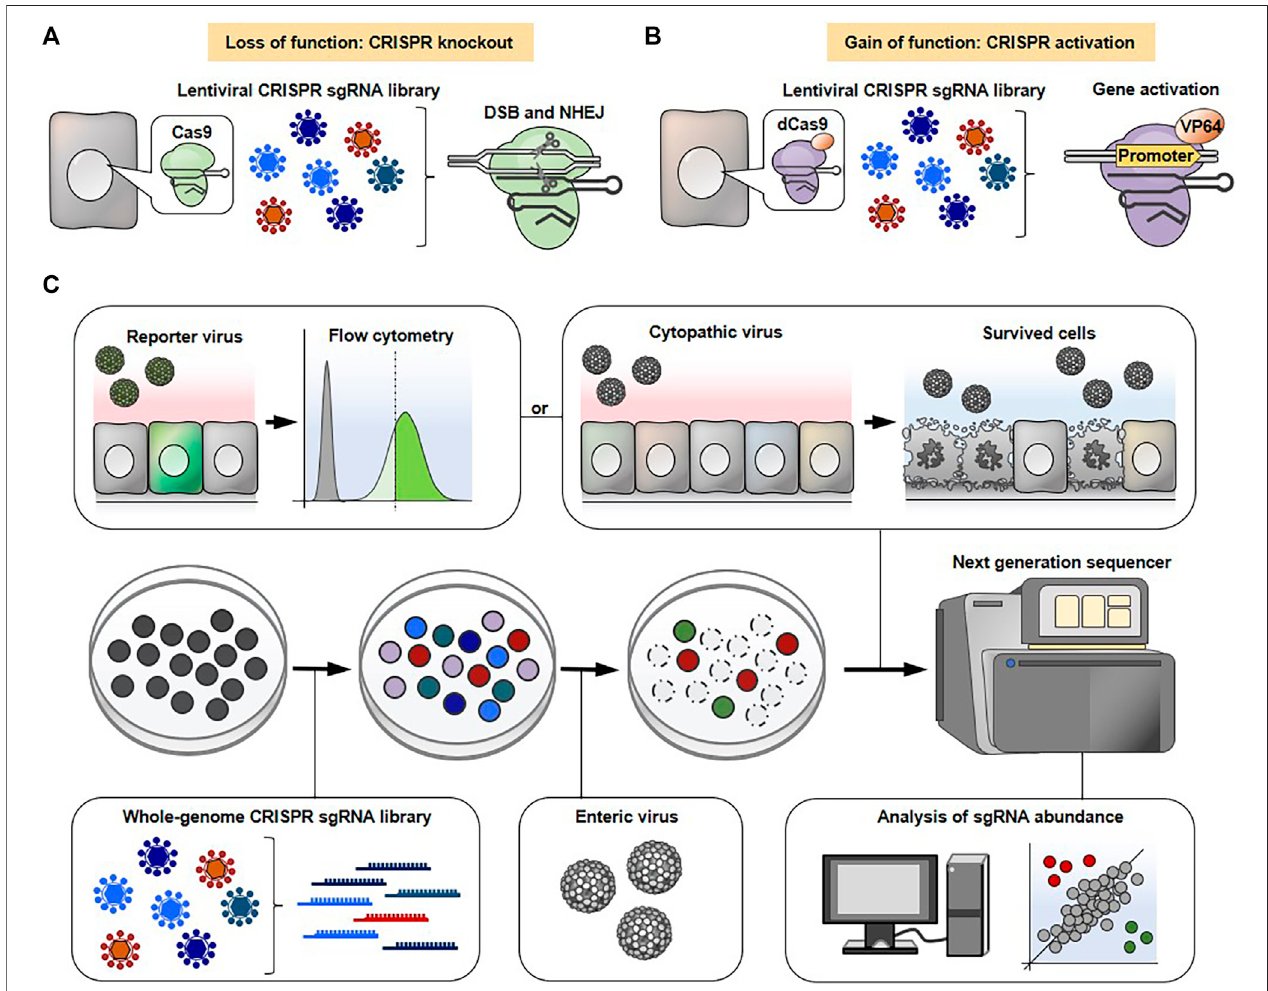
FIGURE 2 | General work fl ow for genome-wide CRISPR-Cas9 screens. CRISPR-Cas9 (A) or CRISPR-dCas system (B) is used toconduct loss-of-function (A) or gain-of-function (B) screens, respectively. (C) The cells are transduced with lentivirus containing either a CRISPR knockout sgRNA library (A) or an activation sgRNA library (B) , followed by a cytopathic virus infection. The surviving cells that are expected to confer resistance to lethal infection due to speci fi c gene knockout or overexpression are collected. The sgRNA abundance in surviving cells and uninfected control cells is determined by next generation sequencing to narrow down the gene(s) associated withphenotypic changes. Alternatively,the cellsare infected withareporter virus (e.g.,GFP or mCherry) and the cellsexpressing theviral geneat high or low levels are sorted using fl ow cytometry, followed by next generation sequencing.